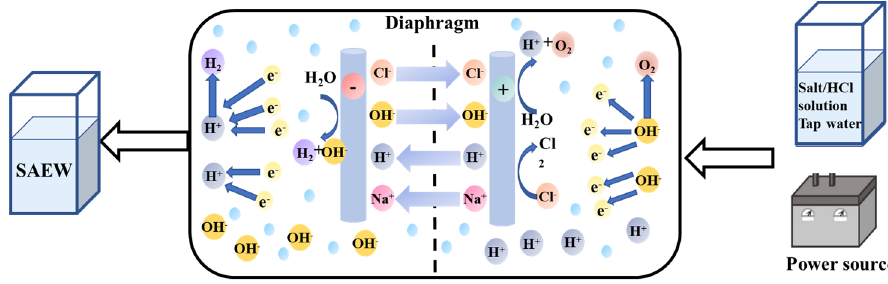
Figure 3. The schematic illustration for slightly acid electrolyzed water application [56].